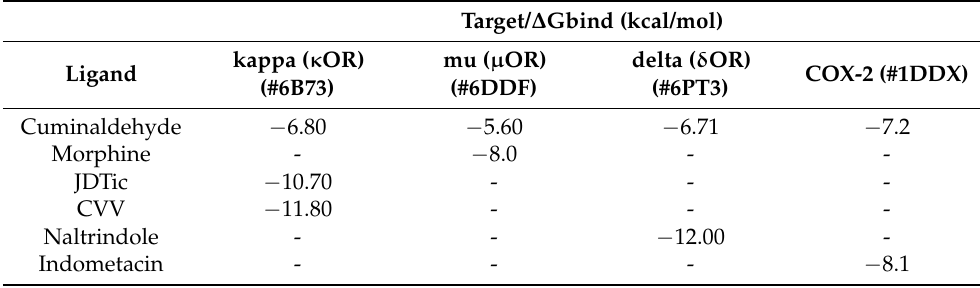
Table 1. Free binding energies obtained by molecular docking of cuminaldehyde and/or drugs with the OpRs of kappa, mu and delta